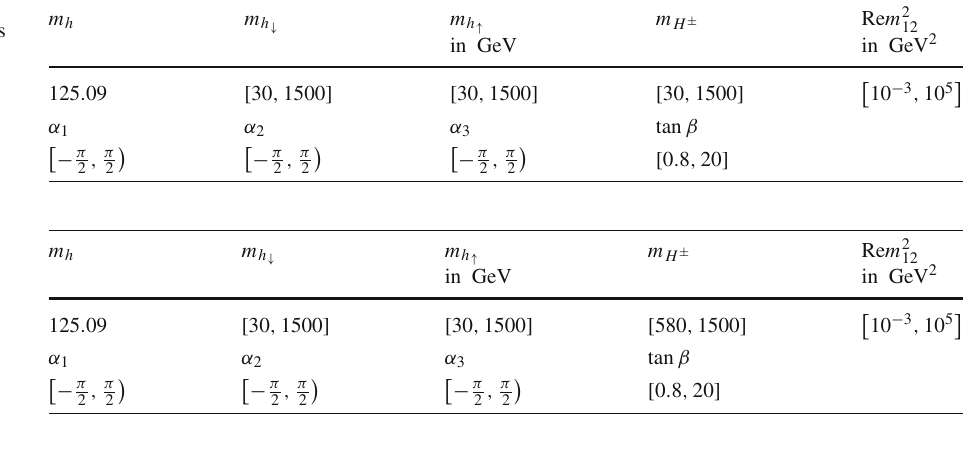
the counterterms δ Im λ 6 , 7 we have δ Im λ 6 = δ Im λ 7 . 12 The wall velocity which is an input parameter in BSMPT v2.2